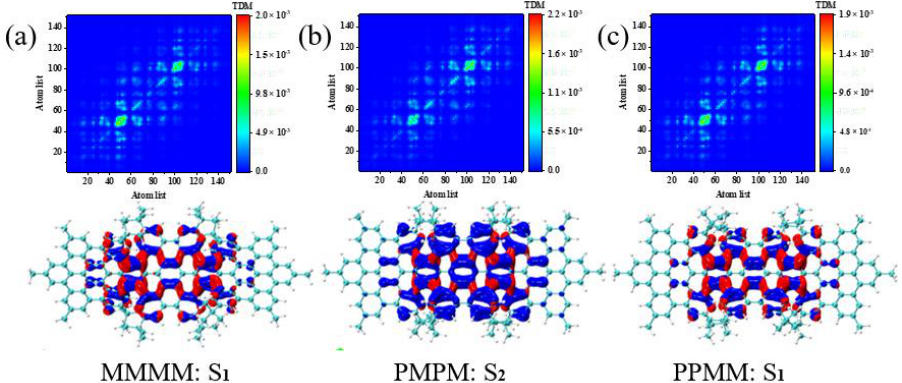
Figure 4. The TDM and CDD of the excited states of three isomeric molecules at 390–500 nm in the spectrum. ( a ) The TDM and CDD diagrams of S1 of MMMM at 477 nm. ( b ) The TDM and CDD diagrams of S2 of PMPM at 428 nm. ( c ) The TDM and CDD diagrams of S1 of PPMM at 472 nm.